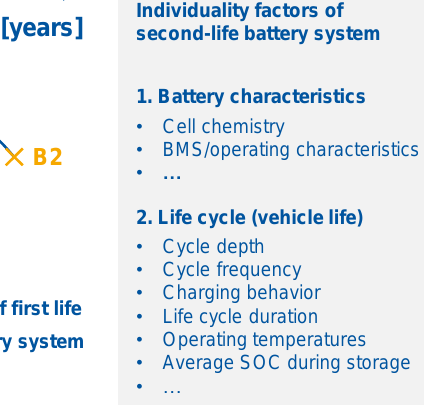
Figure 2. Individuality factors of second-life battery systems.